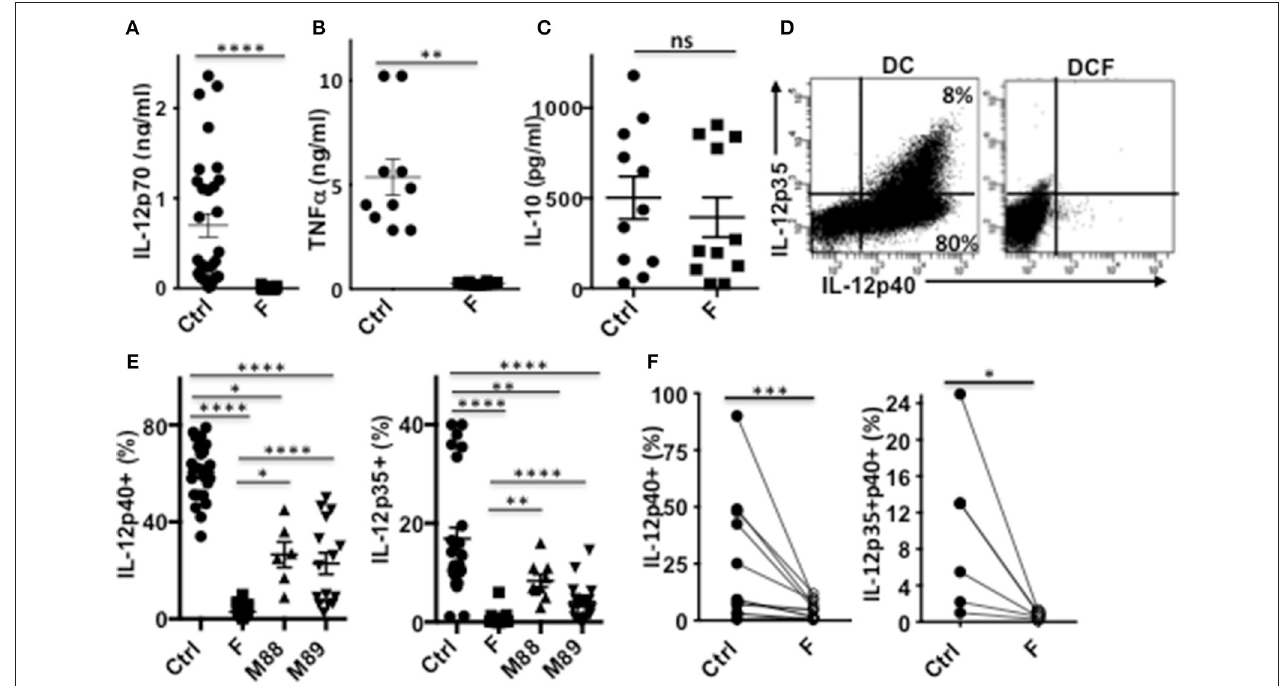
FIGURE 4 | DC exposure to F. prausnitzii switches their cytokine profile from pro-inflammatory to anti-inflammatory . IL-12p70 (A) , TNF-a (B) , and IL-10 levels (C) secreted in response to LPS by DC exposed or not (Ctrl) to Fprau at the beginning of their differentiation. (D) Representative dot plot of intracellular IL-12p35 and p40 co-labeling in LPS-stimulated DC exposed or not to F. prausnitzii . (E) LPS-induced IL-12p40 ( n = 6–24) and IL-12p35 ( n = 9–27) expression by DC exposed or not (Ctrl) to indicated bacteria (ratio:1:1) during the last 48h. (F) IL-12p40 ( n = 12) and p35 ( n = 6) expression by myeloid DC maintained for 24h in culture with or without F. prausnitzii , and then stimulated 12h with LPS. Wilcoxon test. * p < 0.05, ** p < 0.005, *** p < 0.0005, **** p < 0.00005.